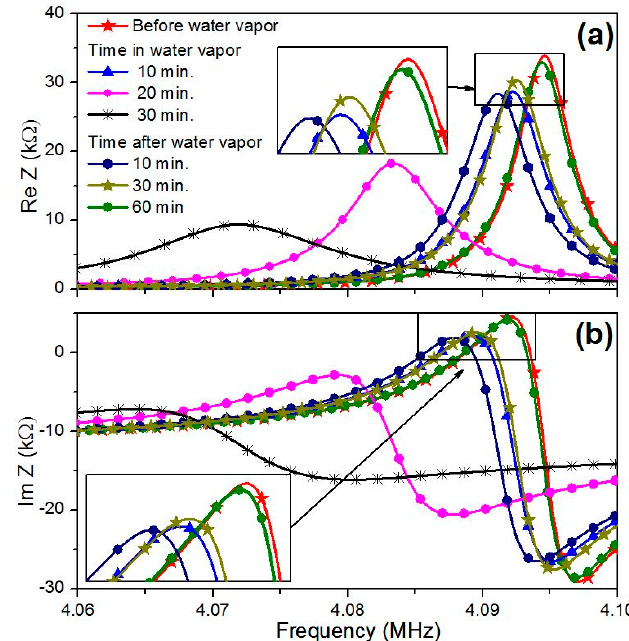
Figure 6. Frequency dependencies of ( a ) the real and ( b ) imaginary parts of the complex electrical impedance of the AT-quartz resonator loaded by the mushroom P. eryngii mycelium film.